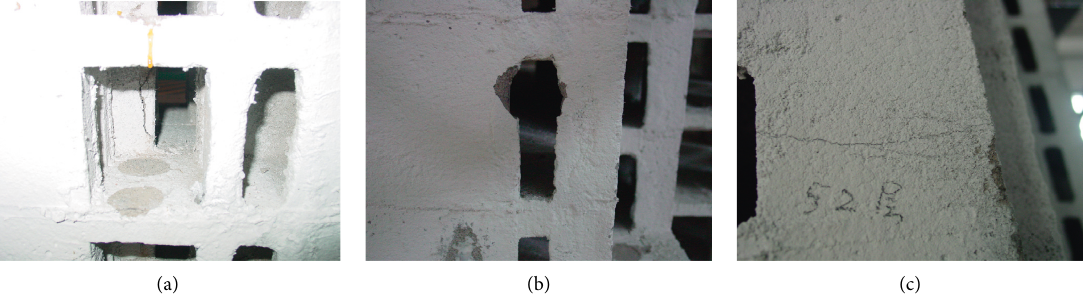
Figure 5: Damages of the test model after seismic input: (a) floors 1 to 3; (b) 42 nd floor; (c) 52 nd floor. Table 7: Dynamic characteristic of the model before and after the earthquake excitation. Earthquake